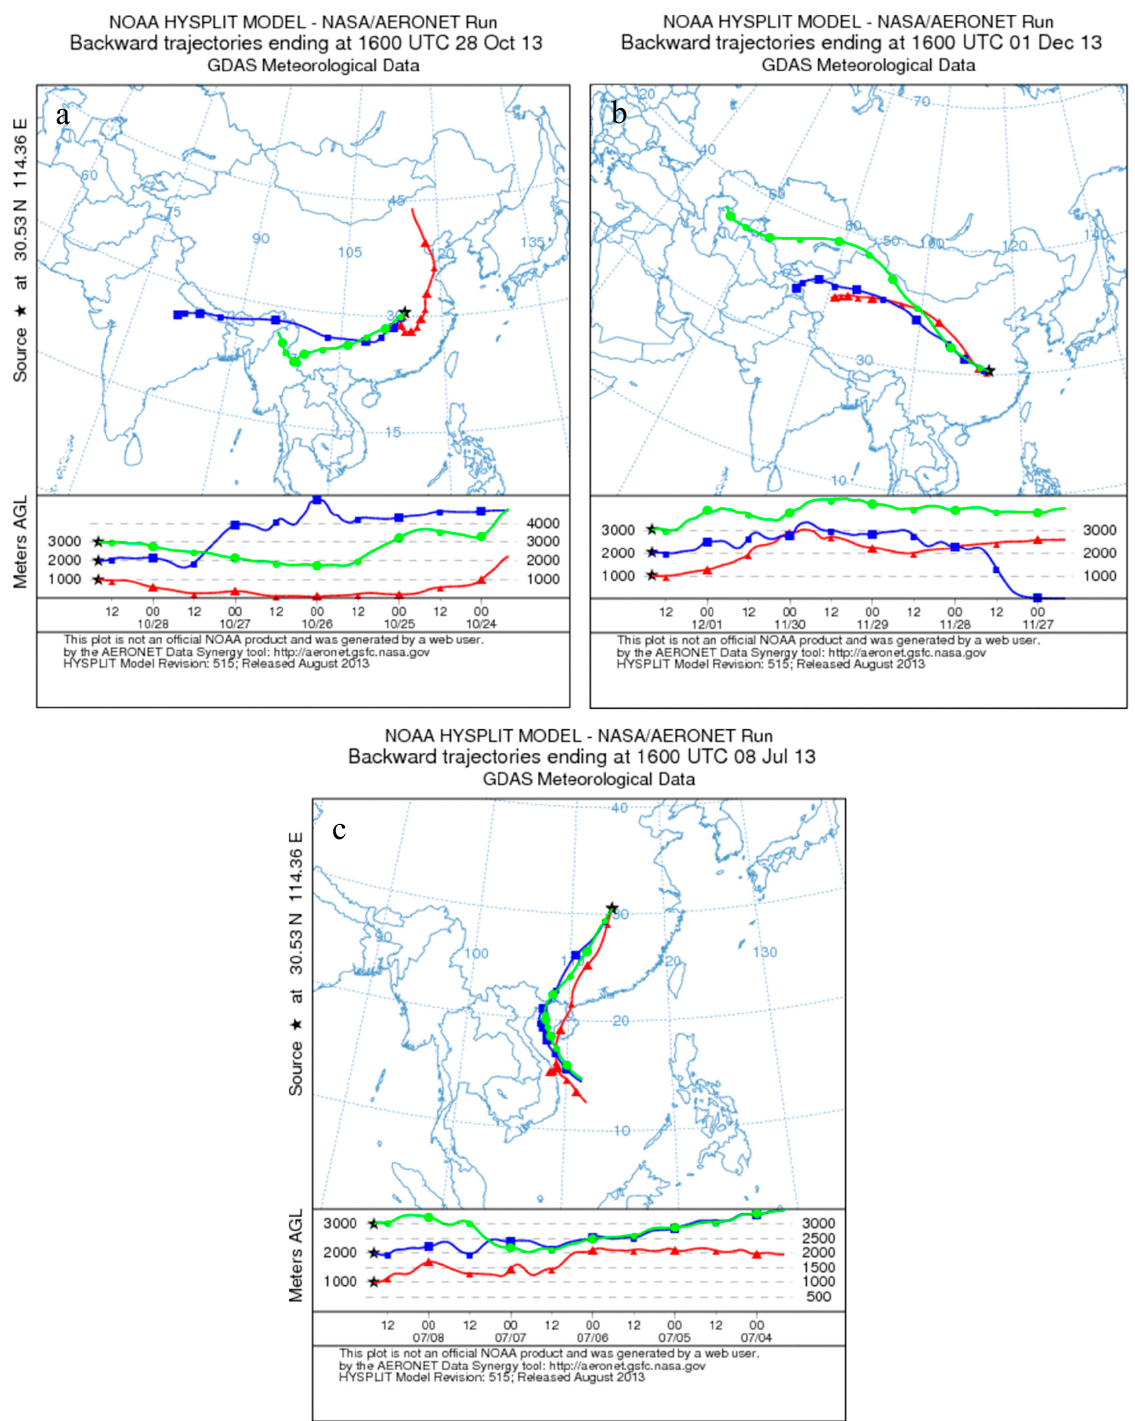
Figure 2. Five-day backward trajectories calculated by HYSPLIT ending at Wuhan at 1000 m (triangles), 2000 m (squares), and 3000 m height (circles) on ( a ) 29 October 2013; ( b ) 2 December; and ( c ) 9 July 2013, at 0000 BST ( i.e. , UTC + 8) for the corresponding case.